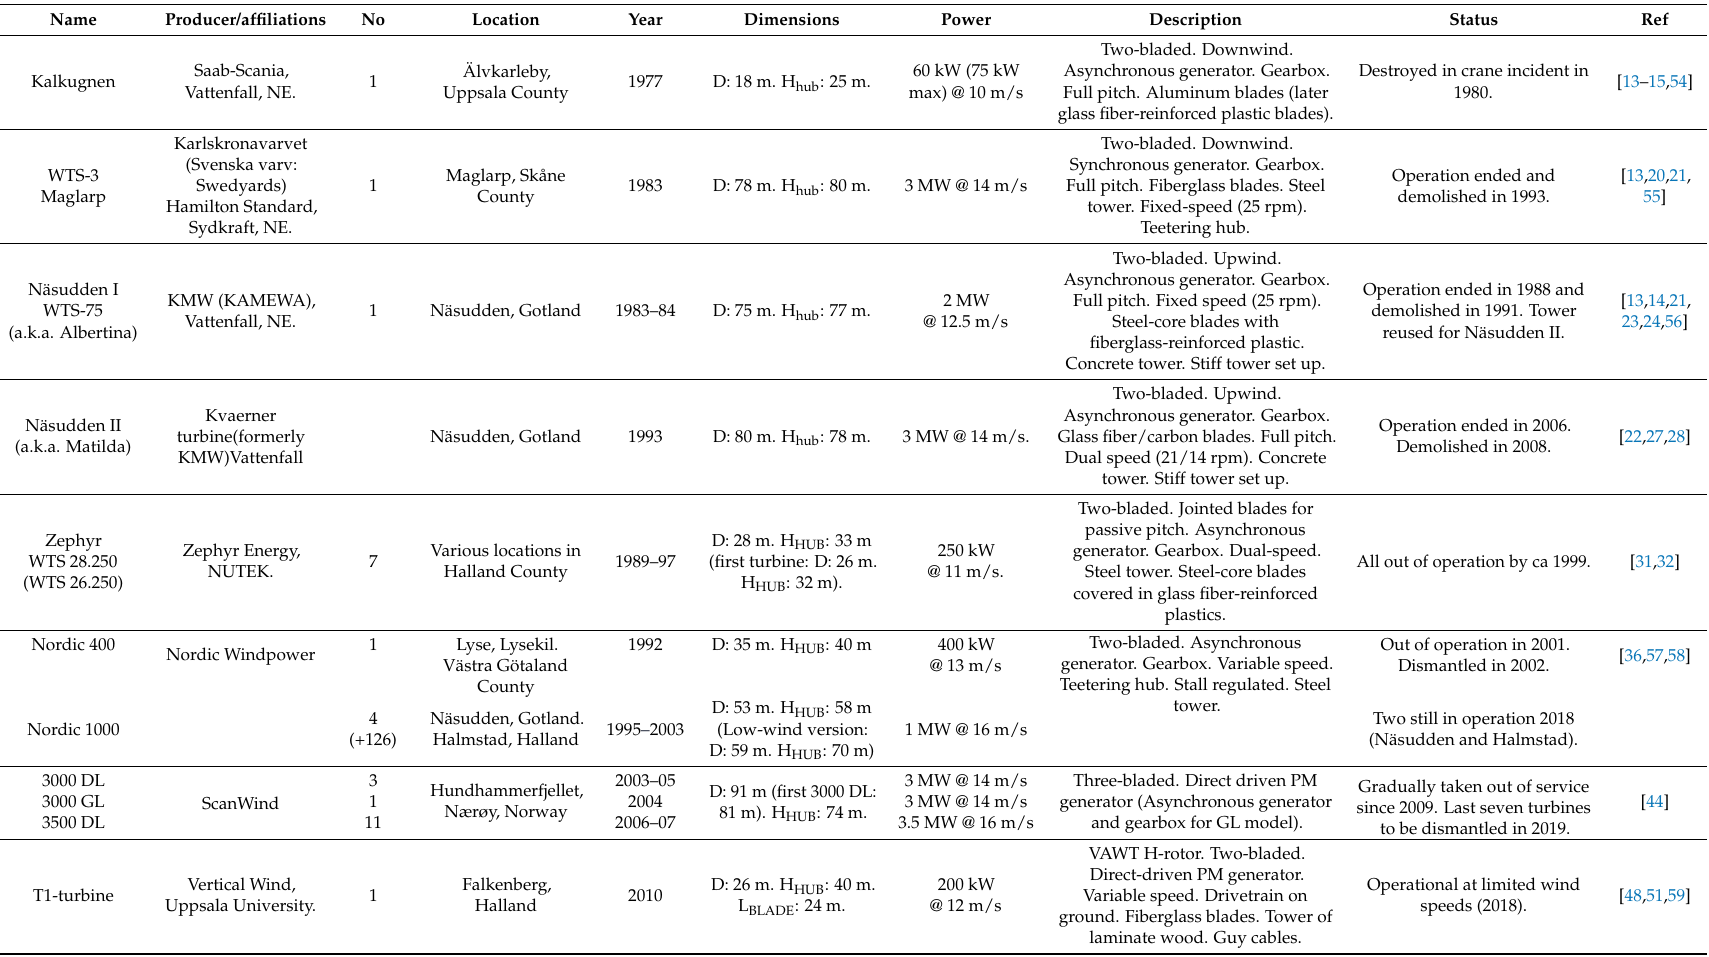
Table 1. Built Swedish wind turbines/prototypes of at least 100